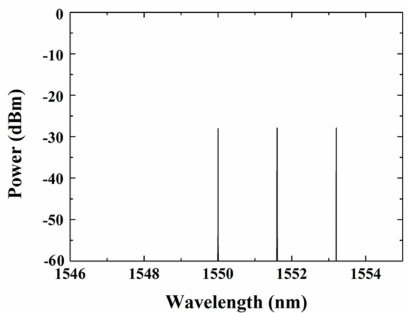
Figure 9. The spectrum of the even channels at the output port 1 with the drop process.